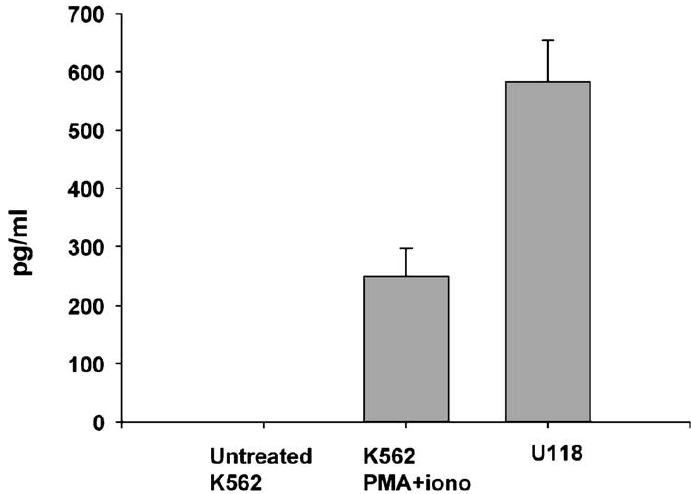
Fig. 4D. The existence of soluble human IL-13Ra2 in supernantant. The soluble human IL-13Ra2 in supernantant of cell culture was detected using a human IL-13Ra2 Elisa kit as described in Section